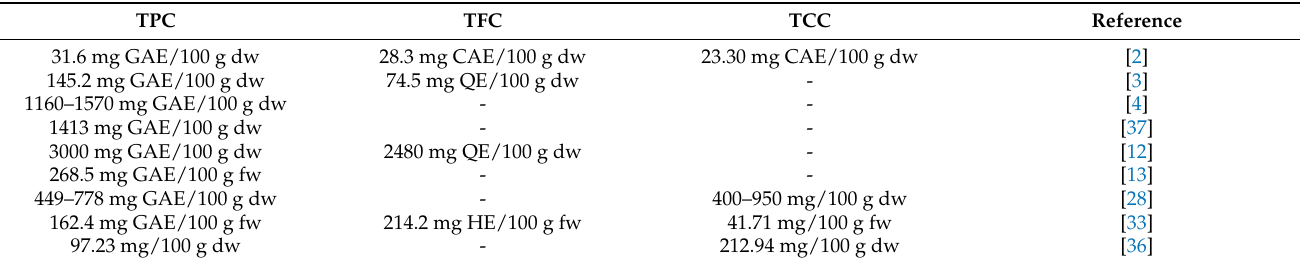
Table 1. Total phenolic compounds (TPC), total flavonoid content and total carotenoid content (TCC) of goji berries according to different